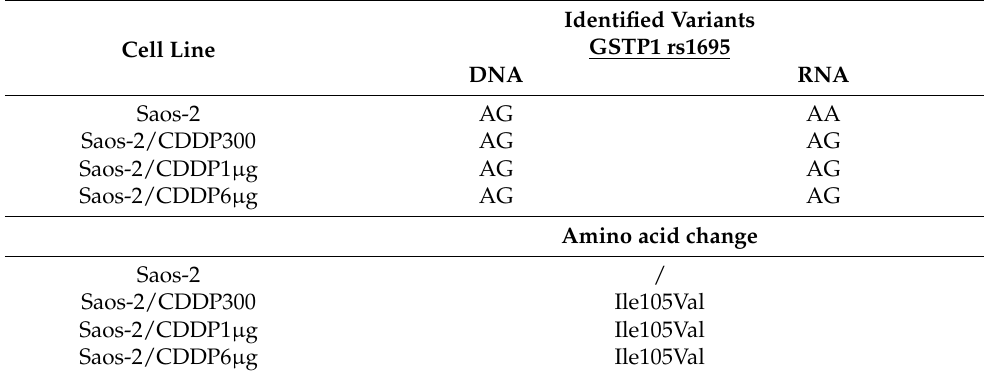
Table 5. RNA single nucleotide polymorphism (SNP) of GSTP1 gene detected in Saos-2 cisplatin (CDDP)-resistant variants compared to their parental cell